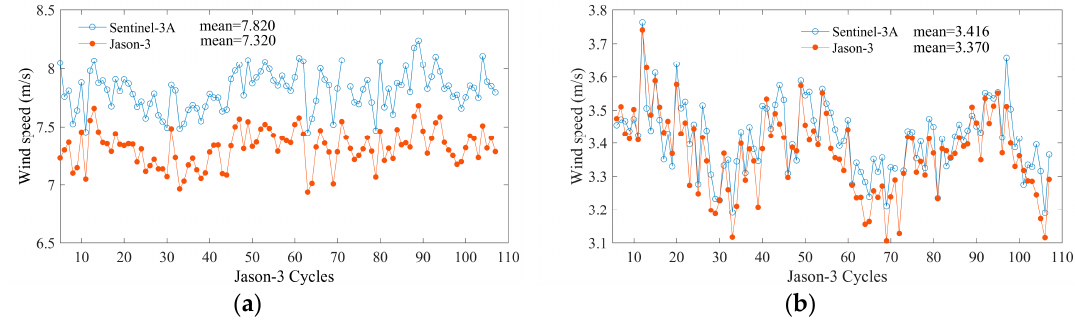
Figure 28. Comparison of cycle by cycle ( a ) means and ( b ) standard deviations of wind speeds between Sentinel-3A and Jason-3 with Jason-3 repeat cycles.